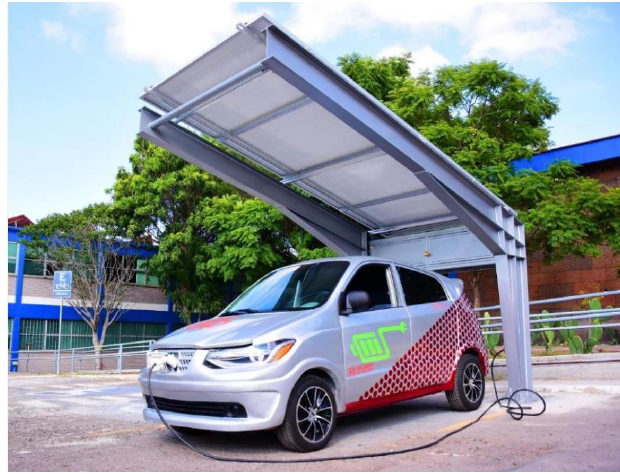
Figure 3. Self-assembly EV used for experimental tests for the estimation of SOC by means of GA and multivariate regression.